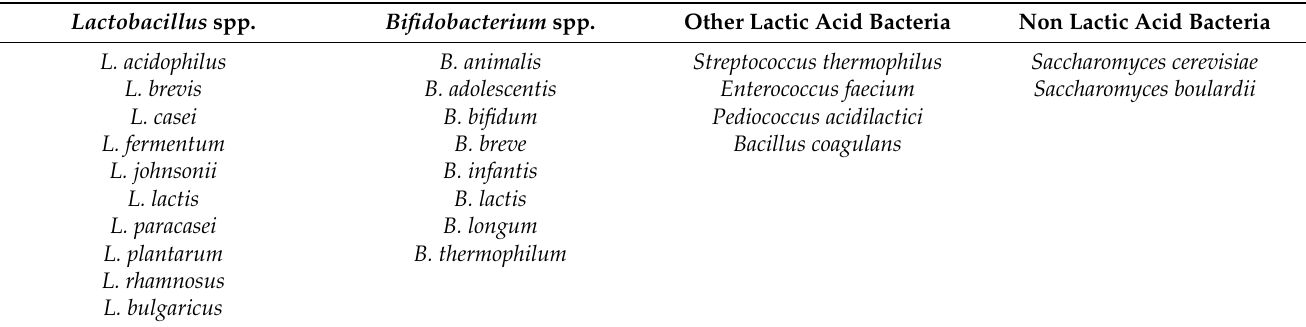
Table 1. Microorganisms considered as